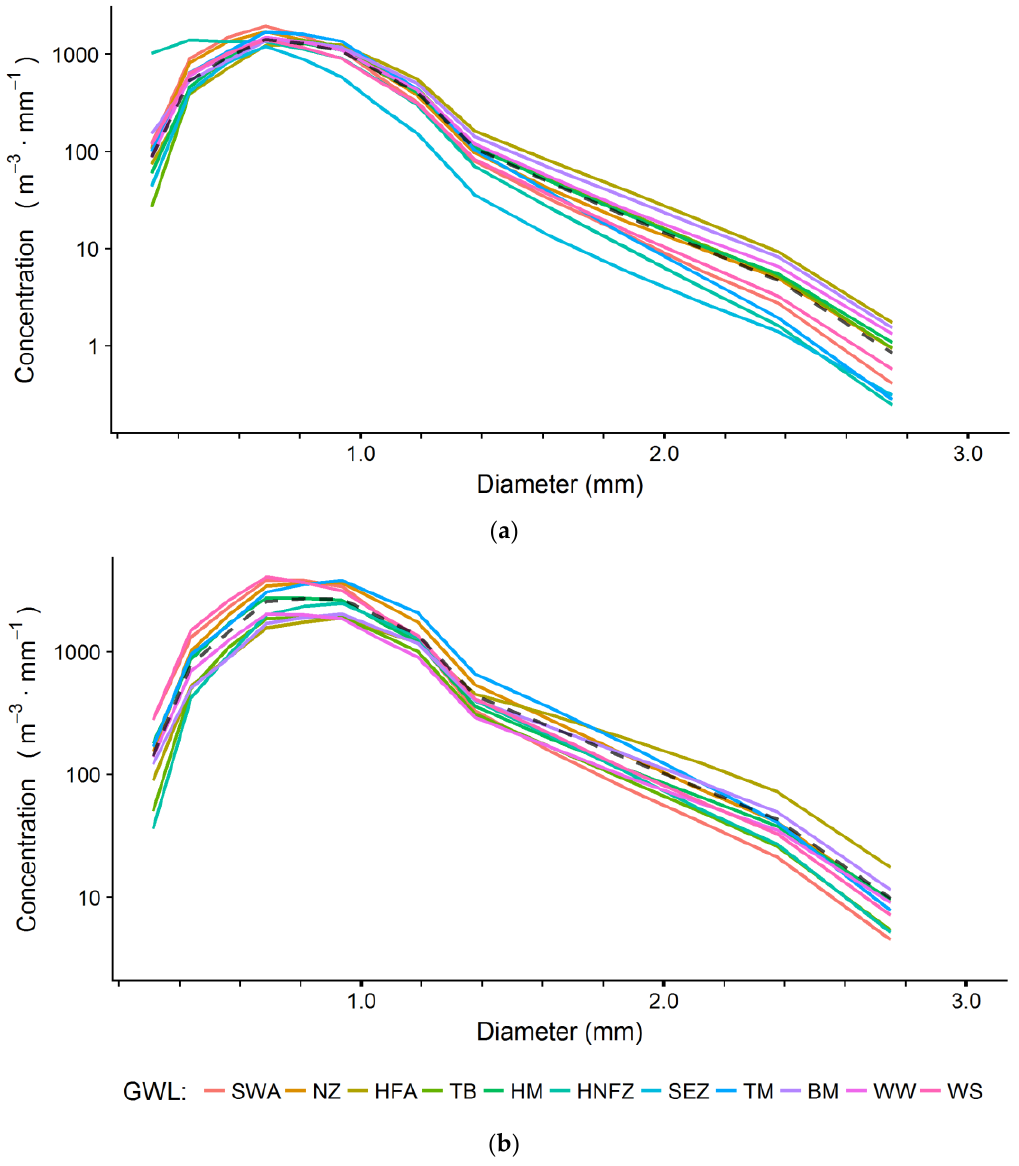
Figure 4. Mean concentrations (number of drops per 1 m 3 of air volume and per 1 mm of the diameter range (A4)) in ( a ) stratiform rain and ( b ) convective rain. To aid the interpretation, the plot is limited to a selection of GWLs that demonstrated distinct DSDs. The dashed black line indicates the mean DSD in both rain types regardless of GWL.